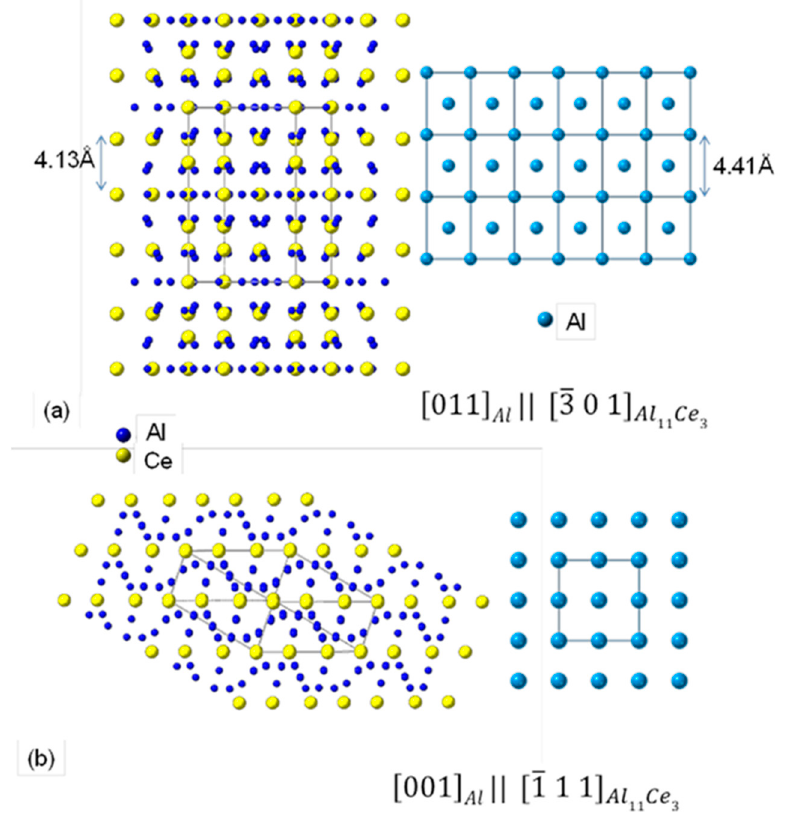
Figure 18. Projections of the Al 11 Ce 3 and Al crystal structures showing the (cid:4670)0 1 1(cid:4671) Al ║ (cid:4670)3(cid:3364) 0 1(cid:4671) Al11Ce3 ( a ) and (cid:4670)0 0 1(cid:4671) Al ║ (cid:4670)1(cid:3364) 1 1(cid:4671) Al11Ce3 ( b ) orientation relationships. Images were modelled with the CrystalMaker ®